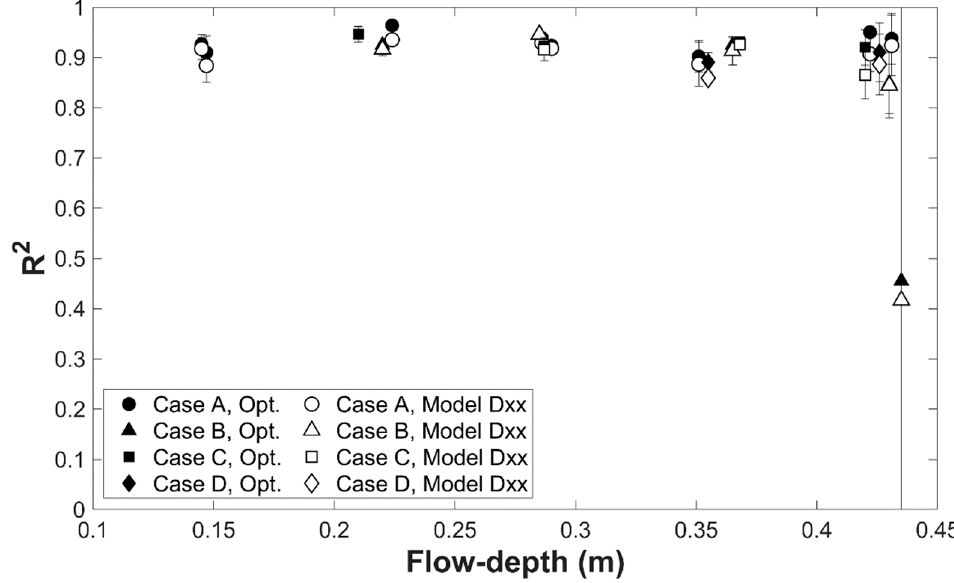
Figure 14. Correlation values R 2 for comparisons between experimental data and down-stream profile prediction for both the models where t is optimized values and and D xx is predicted (Model Dxx) and the model with t and D xx optimized to give best possible fit to data (Opt.).